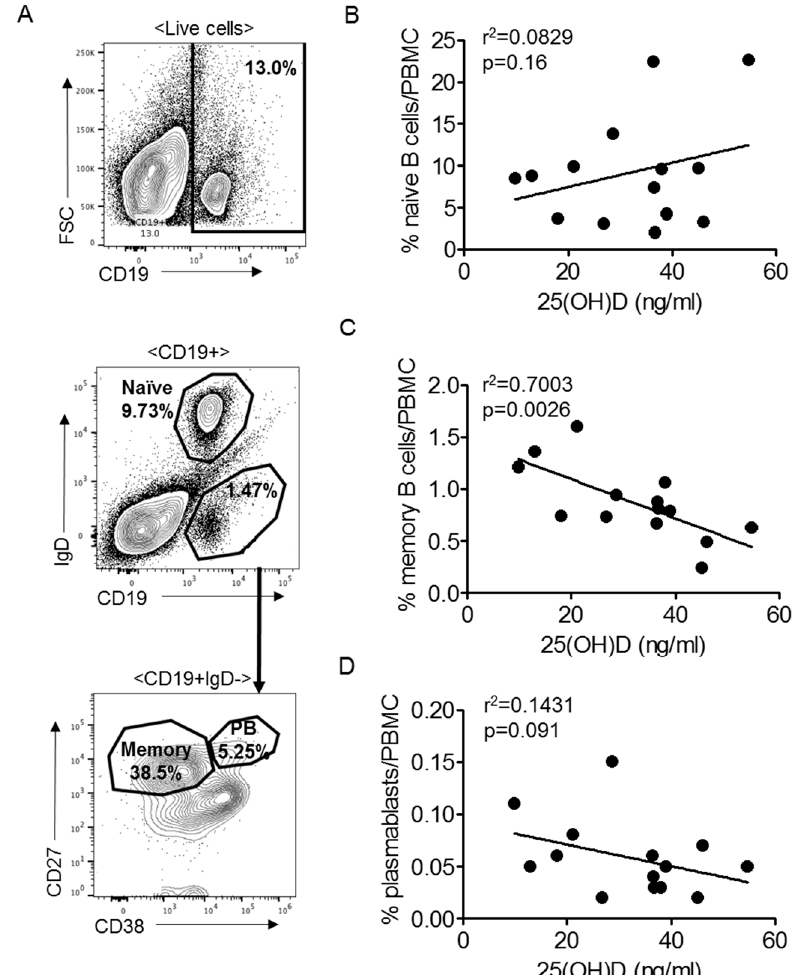
Figure 6. Memory B cells are negatively correlated with vitamin D levels in SLE patients. ( A ) Gating strategy for Figure 25(OH)D levels against circulating ( B ) naïve B cells (CD19 + IgD + ), ( C ) memory B cells (CD19 + IgD-CD27 + CD38-) and ( D ) plasmablasts (CD19 + IgD-CD27 + CD38 + ) displayed as percent of live cells. Each symbol represents an individual patient, n = 14. PB = plasmablast.